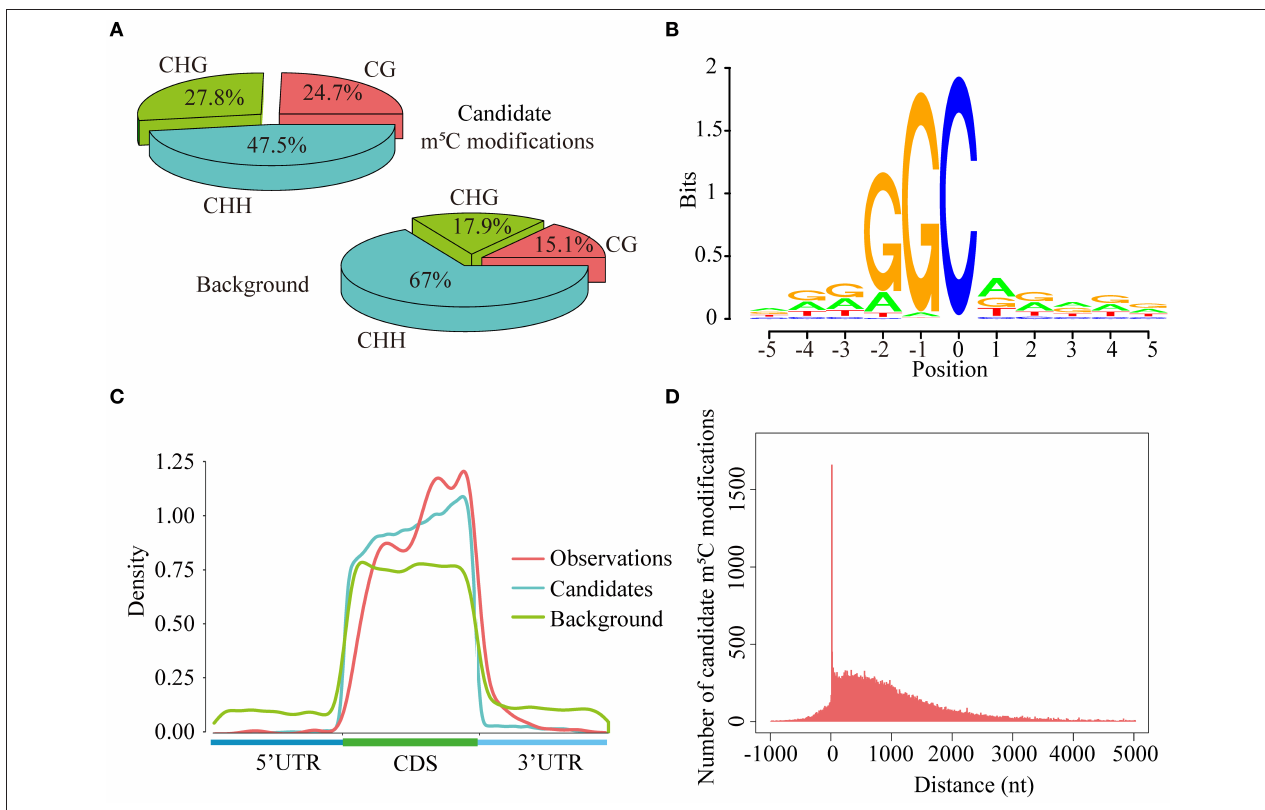
FIGURE 7 | Transcriptome-wide annotation of m 5 C modifications using PEA-m5C. (A) The proportions of candidate m 5 C modifications and all cytosine sites in three different sequence contexts: CG, CHG and CHH (where H = A, C, or U). (B) The sequence logo of candidate m 5 C modifications. The position of candidate m 5 C modifications is defined as 0. (C) The distribution of observed m 5 C modifications (positive samples in the DatasetCV), candidate m 5 C modifications, and all cytosine sites (background) along the 5 ′ -UTR, CDS and 3 ′ -UTR, normalized for transcript length. (D) The distribution of candidate m 5 C modifications relative to translational start sites. The position of translational start sites is defined as 0.